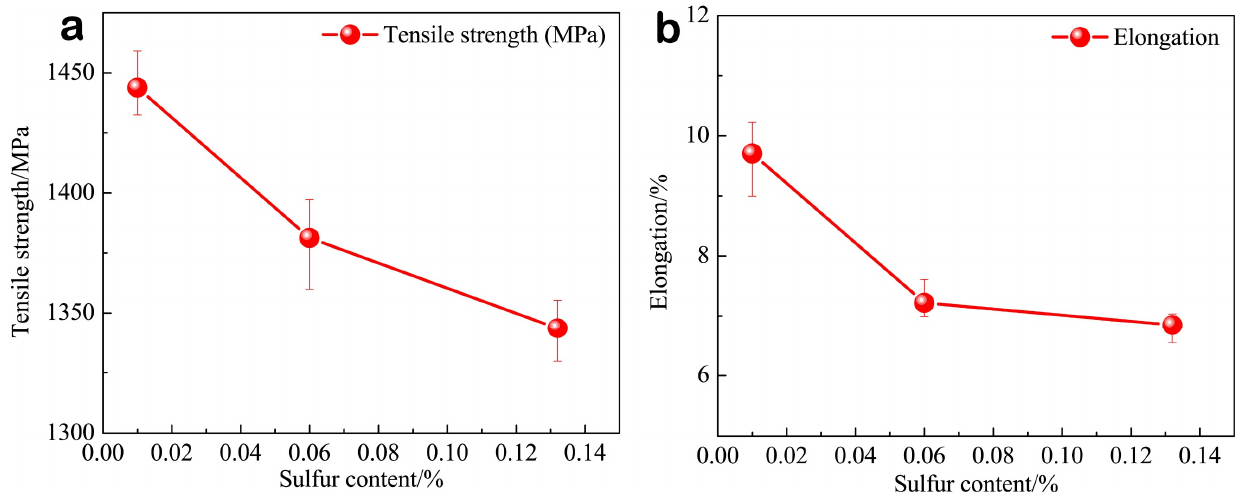
Figure 13. Tensile strength and elongation result. ( a ) Tensile strength; ( b )